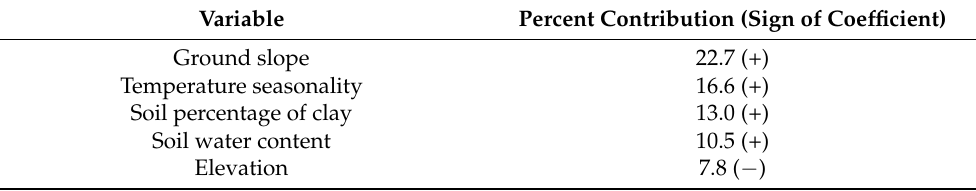
Table A2. Variable contribution and sign of coefficient for the Generalized Linear Model.